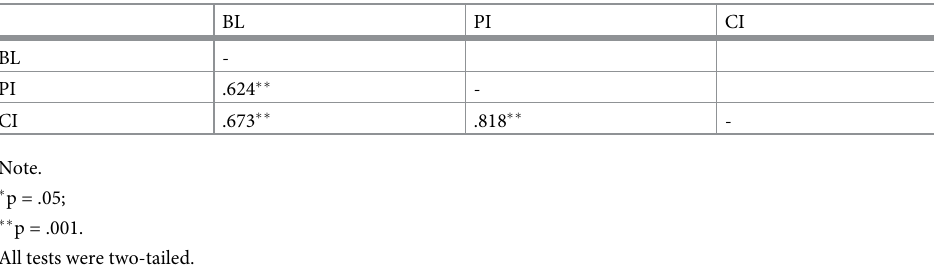
�� p = .001. All tests were two-tailed.